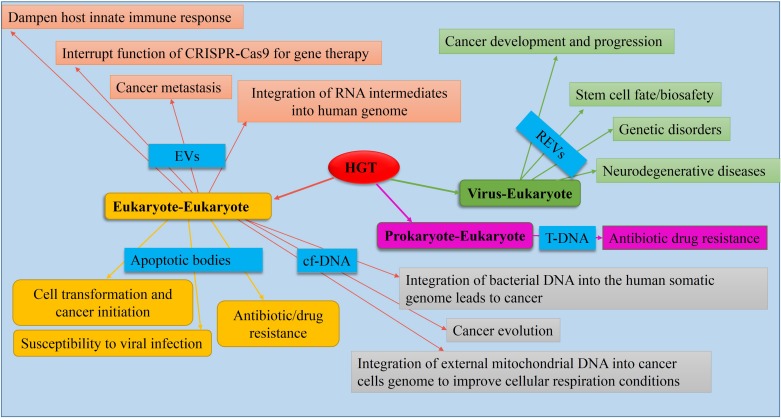
Causes and consequences of HGT in eukaryotes. Mediators (causes) are shown in blue boxes. Data obtained from de la Taille et al. (1999), Holmgren et al. (1999), Bergsmedh et al. (2001), Fronzes et al. (2009), Trejo-Becerril et al. (2012), Berridge et al. (2015), Hancks and Kazazian (2016), Lacroix and Citovsky (2016), Nishida-Aoki et al. (2017), Robinson et al. (2017), Gao et al. (2018), Jang et al. (2019), Kawamura et al. (2019), Ono et al. (2019), Schumann et al. (2019).